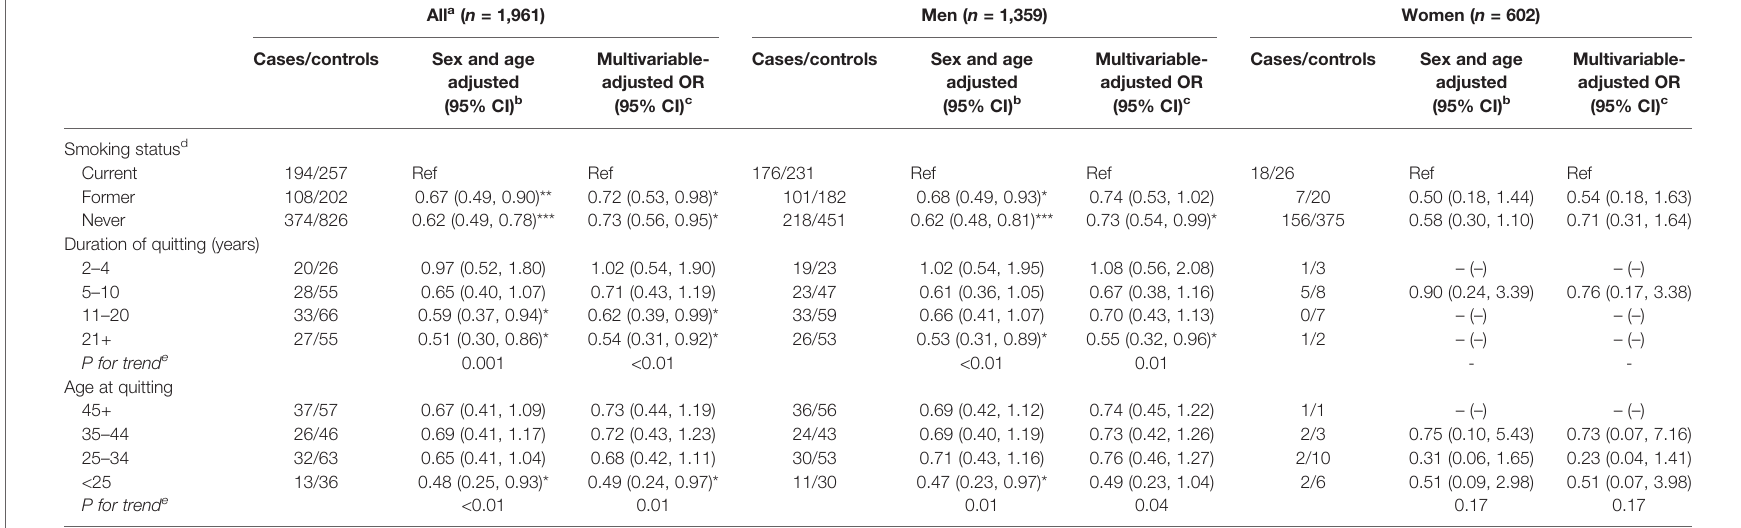
TABLE 2 | Associations between quitting smoking and nasopharyngeal carcinoma (cases vs . controls) in subjects aged 18 – 65 by